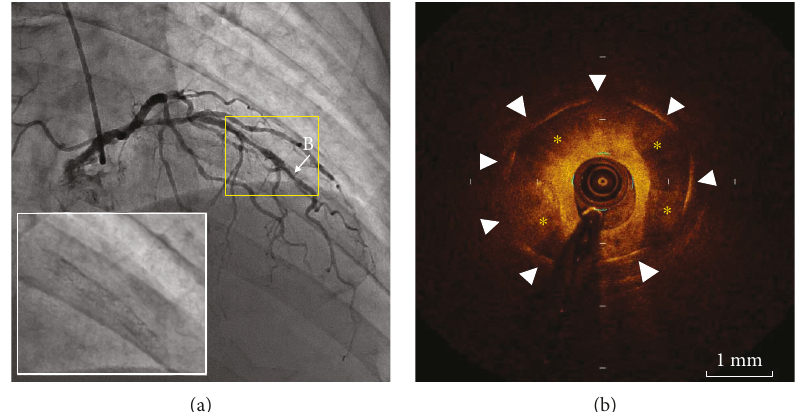
Figure 1: First time coronary angiography and corresponding OCT image. (a) Angiography demonstrated tandem stenotic lesions within the previously implanted stent. (b) OCT revealed severely calci fi ed neointima (asterisks) within well-expanded stent struts (arrowheads) at the distal stenotic site. OCT: optical coherence tomography.